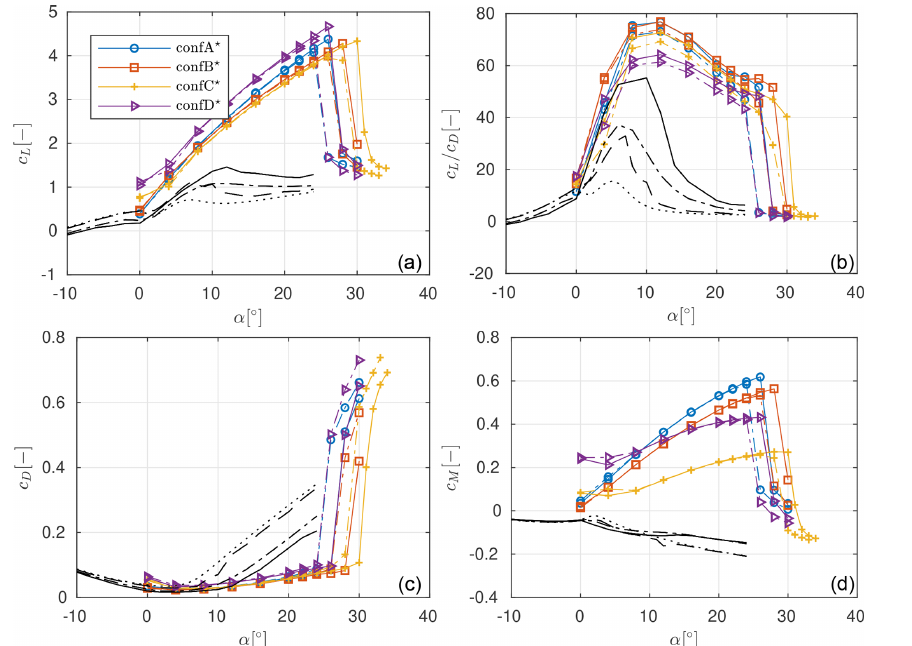
Figure 13. Lift (a) , glide ratio (b) , drag (b) , and pitching moment (d) polars as obtained from CFD for the slat configurations optimized for maximum aerodynamic efficiency using the integral design strategy. The coefficients for the clean ( − ) and tripped ( − . ) DU40 profile only as well as the clean ( −− ) and tripped ( ·· ) FFA48 base profile only are shown as well.